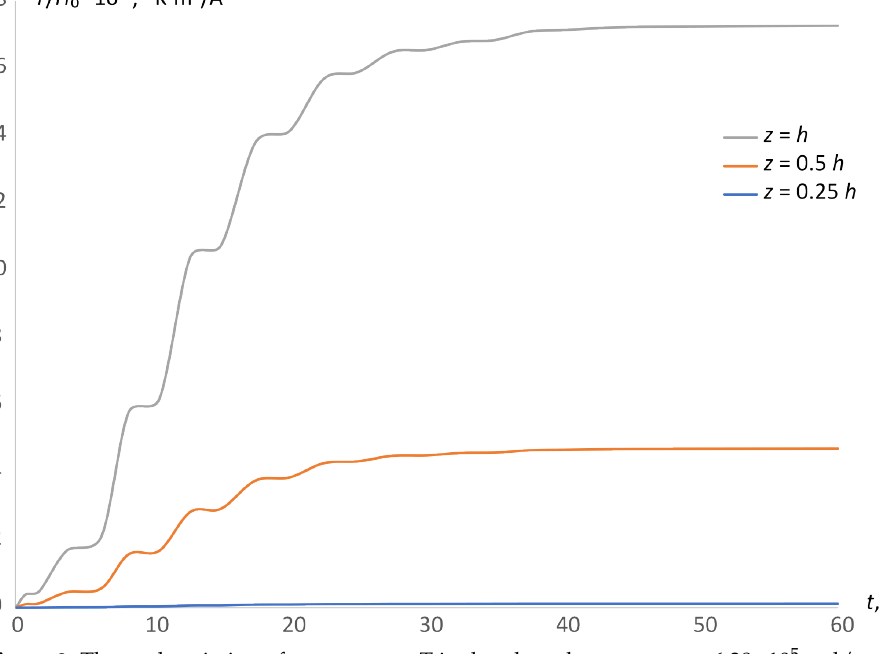
Figure 3. Thermal variation of temperature T in the plate element at ω = 6.28 · 10 5